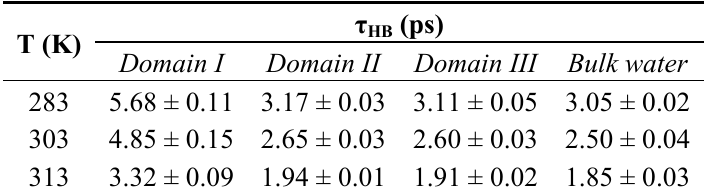
Table 4. Average lifetime of hydrogen bonds between water molecules of different domains a